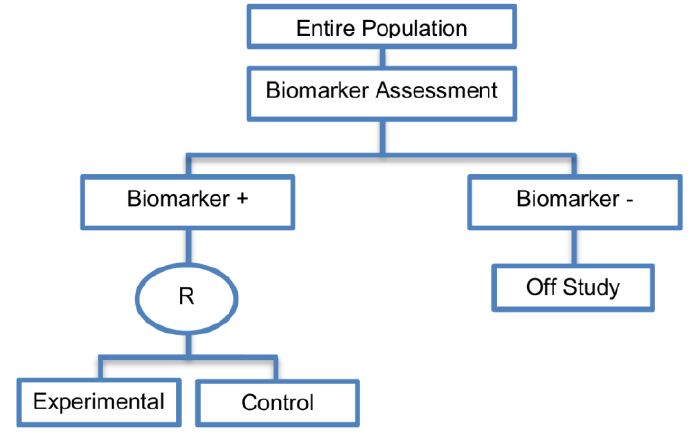
Figure 3. Enrichment designs. “R” refers to randomization of patients.